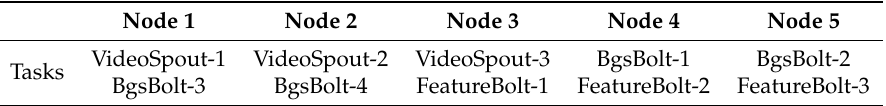
Table 4. Mapping of the target topology’s tasks to the five computing nodes.